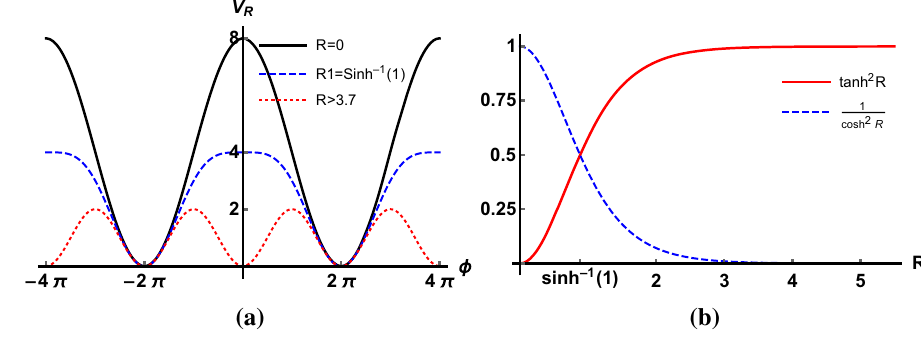
Fig. 1 a Potential of the DSG model; b R -dependence of the coefficients in the potential, which are responsible for the mixing of two sine-Gordon